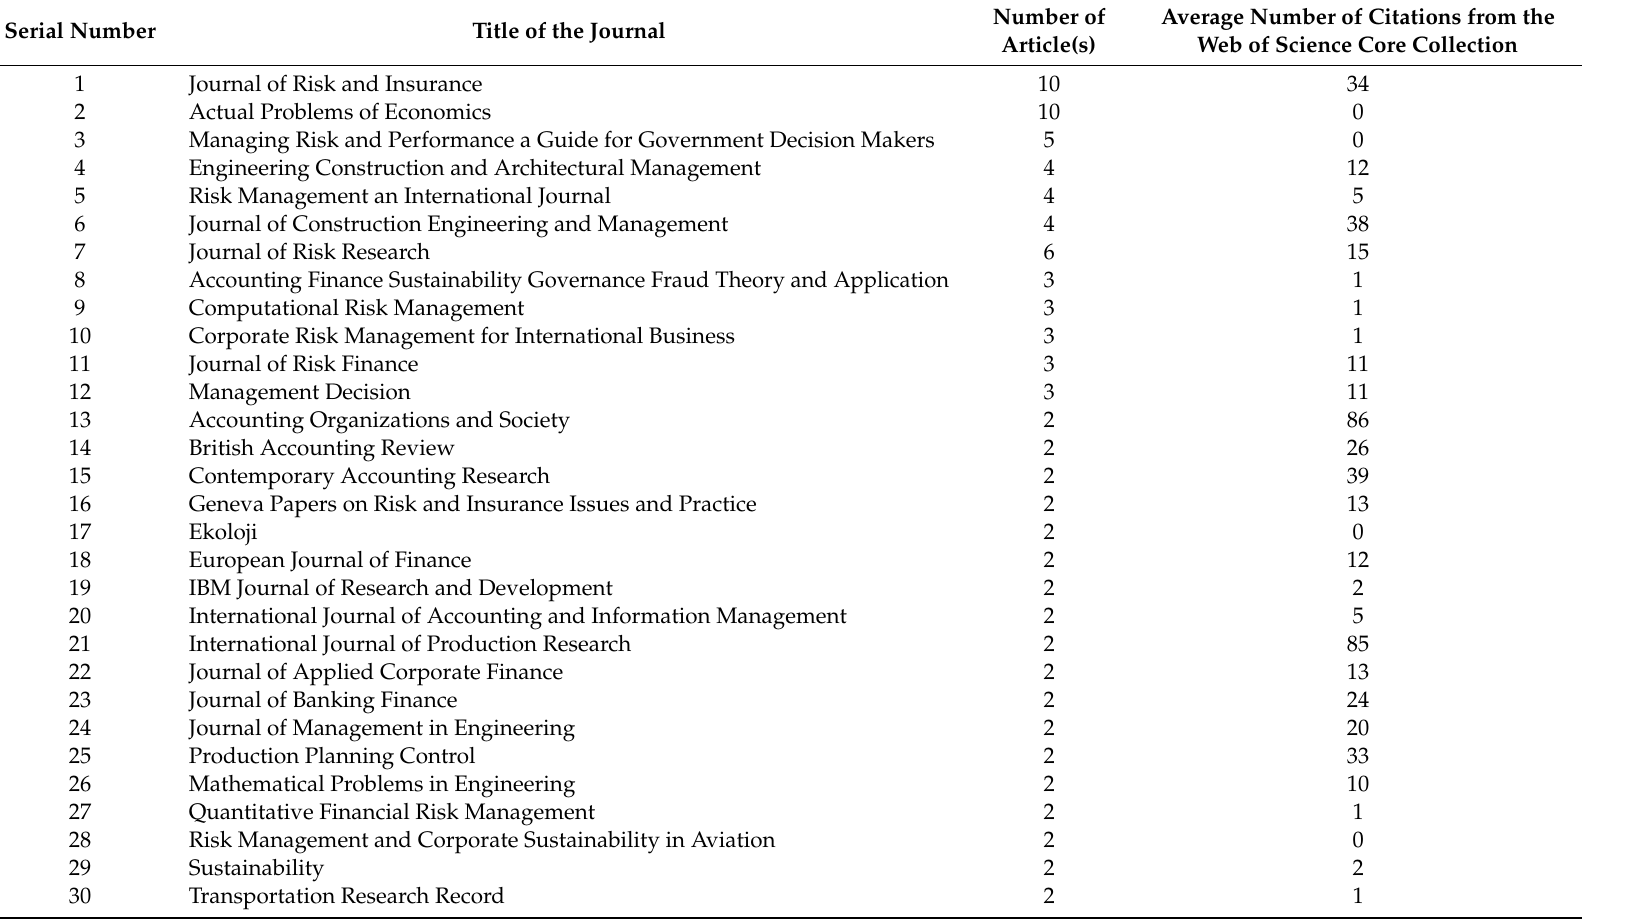
Table 3. The first 30 Source Titles (by record